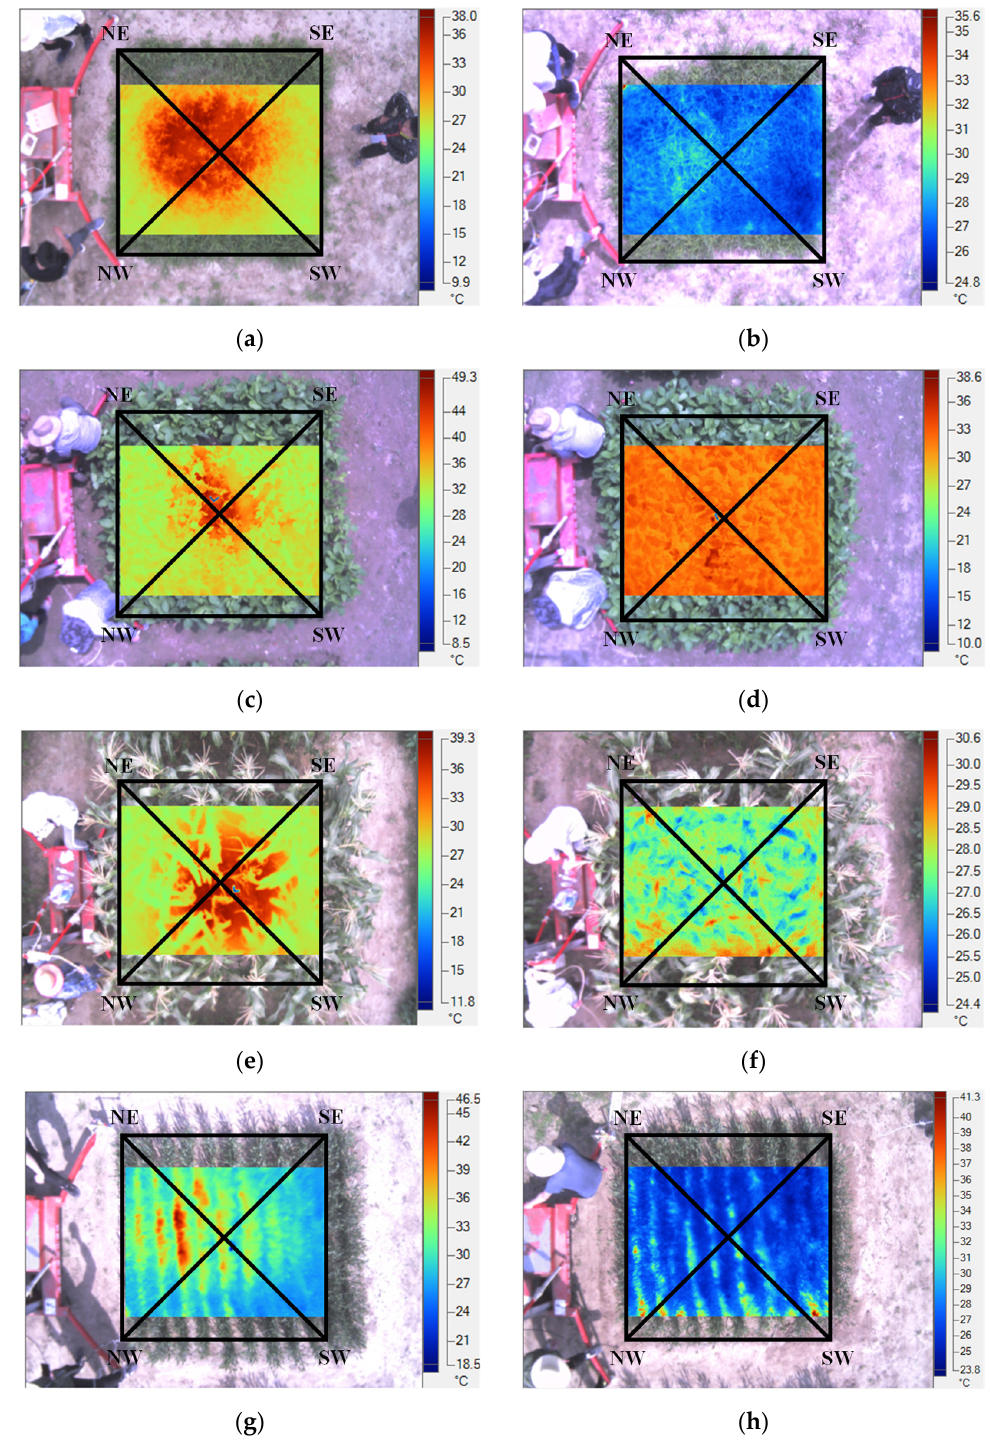
Figure 5. Infrared thermal images of experimental groups: ( a ) grass; ( c ) soybean; ( e ) corn and ( g ) wheat. Infrared thermal images of control groups: ( b ) grass; ( d ) soybean; ( f ) corn and ( h ) wheat.